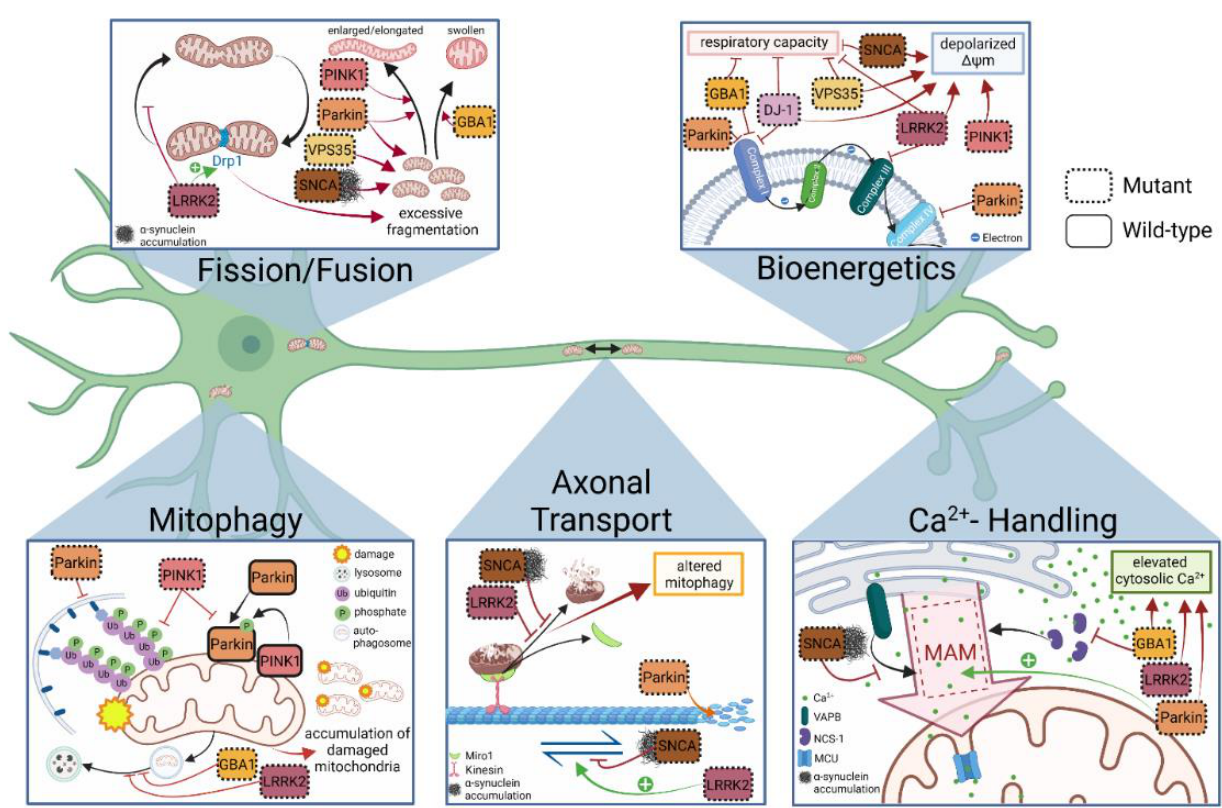
Figure 1. Bioenergetics : GBA1 and Parkin deficiency, with mutant Parkin also being involved in suppression of complex IV proteins. Furthermore, a major bioenergetic burden has been reported in genetic PD neurons with mutations in DJ-1, GBA1, LRRK2, VPS35 and SNCA to result in reduced mitochondrial respiration capacity, or in neurons with mutant LRRK2 , VPS35 , SNCA and PINK1 to suffer from reduced mitochondrial membrane potential ( ∆Ψ m). Fission/Fusion : The balance of fission and fusion has been shown be disrupted in several iPSC-derived models of genetic PD with mutant PINK1 and Parkin leading to enlarged/elongated organelles, and mutant GBA1 to rather swollen mitochondrial structures. Excessive mitochondrial fragmentation has been demonstrated in mutant Parkin and VPS35 neurons, as well as in neurons from SNCA and LRRK2 patients, a phenotype that is suggested to be associated with increased Drp1 activity in the latter. Axonal transport : Aberrant α -syn expression was shown to interfere with anterograde axonal transport, while mutant LRRK2 leads to enhanced mitochondrial motility in human neurons. Alterations of both proteins have also been shown to be involved in Miro1 kinetics by delaying Miro1’s removal from mitochondria, thereby interfering with proper mitochondrial clearance (mitophagy) under conditions of mitochondrial depolarization. Additionally, destruction of microtubules themselves has been reported in Parkin patient neurons. Mitophagy : PINK1/Parkin-dependent mitophagy has been well characterized, hence, not surprisingly, mutant PINK1 and Parkin patient neurons demonstrate impaired mitophagic flux, partially based on studies reporting reduced levels of phosphorylated ubiquitin (Ser65) and impaired recruitment of Parkin to